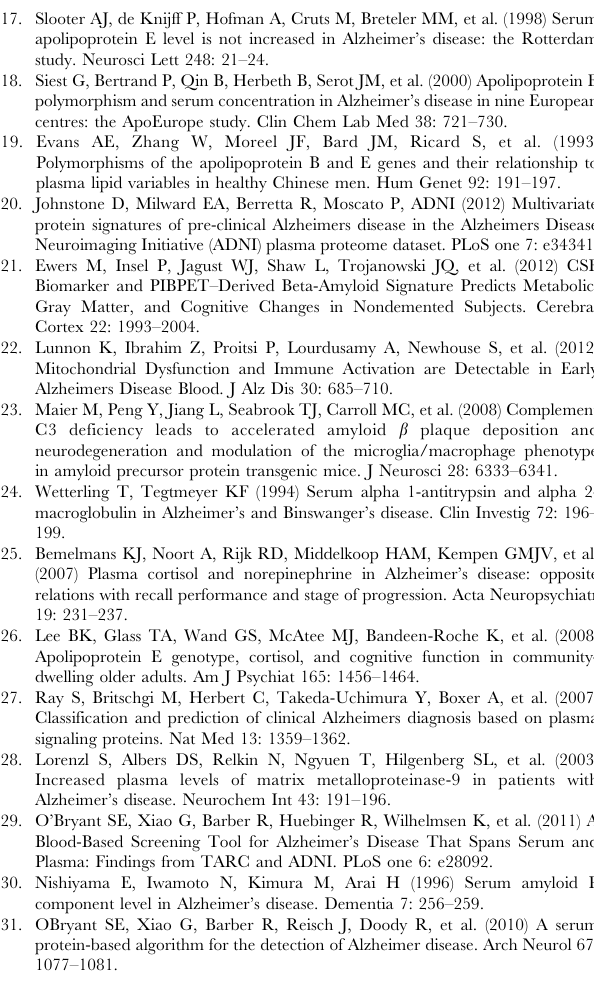
Table S3 Association of markers with AD